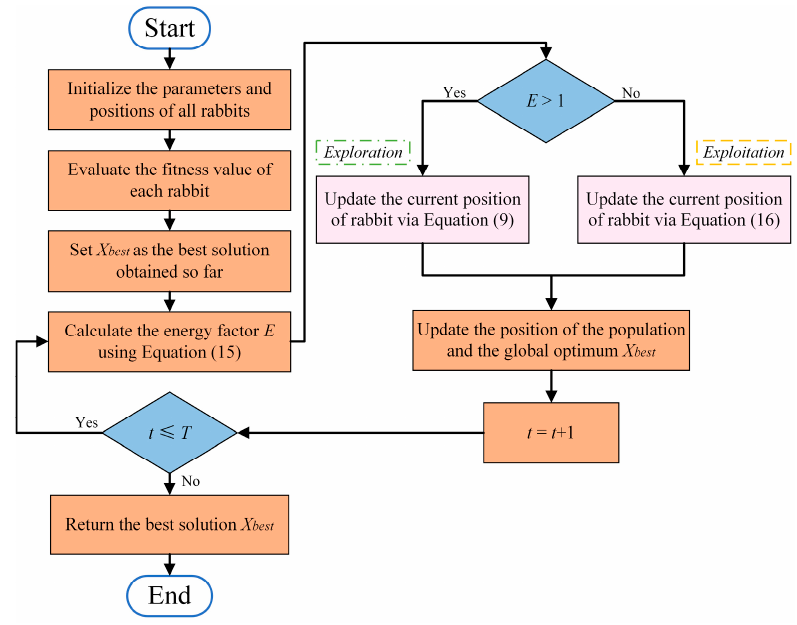
Figure 2. Flow chart of ARO.